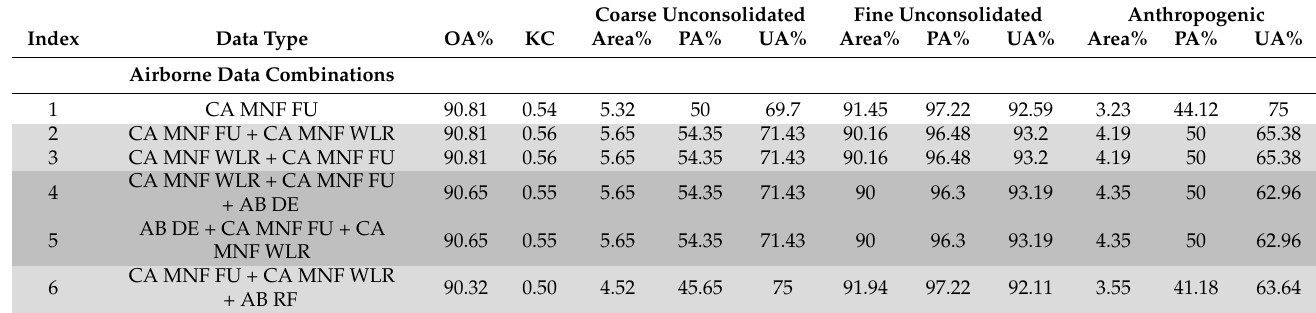
Table A1. Tier 1 substrate component overall and class-specific classification accuracies for airborne and satellite data combinations. Index = unique numerical value; OA% = percent overall accuracy; KC = Kappa Coefficient; Area% = percent area; PA% = percent producer accuracy; UA% = percent user accuracy. Data combinations are ranked by overall accuracy, highest to lowest, and grouped in which overall accuracy and Kappa Coefficient values are the same (alternating groups of white, light grey and dark grey blocks); there is no particular order of importance within those groups. * Denotes the data combination used for the Tier 2 analysis mask.